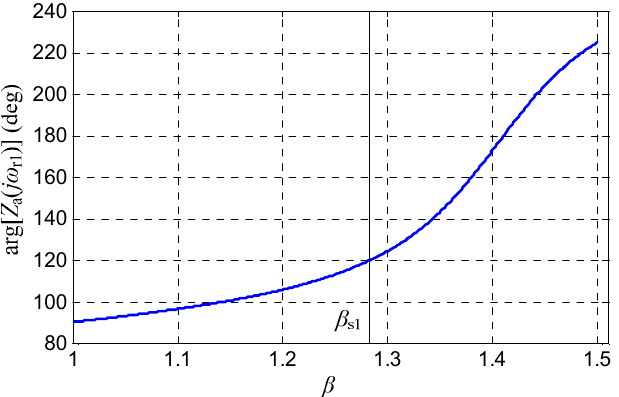
ω β as β varies from 1 to δ r1 )] and